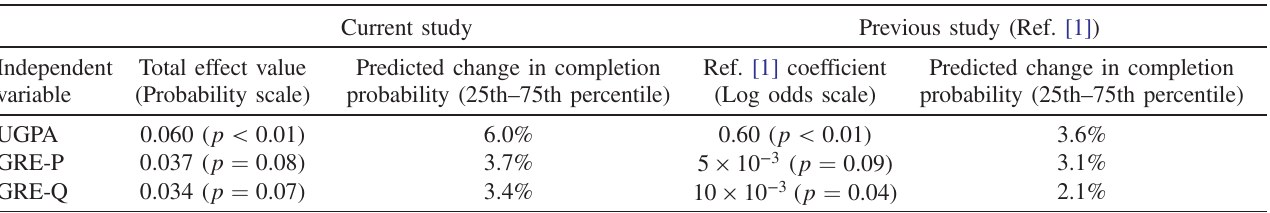
TABLE V. Comparison of results from the current study to results presented by Miller et al. [1] in which the authors predict Ph.D. completion using a logistic regression model. Despite using different statistical methods and omitting program tier as a predictor in our model, we observe that the results obtained in this study are qualitatively consistent with those reported previously. In both cases, UGPA is the strongest predictor of Ph.D. completion among admissions metrics